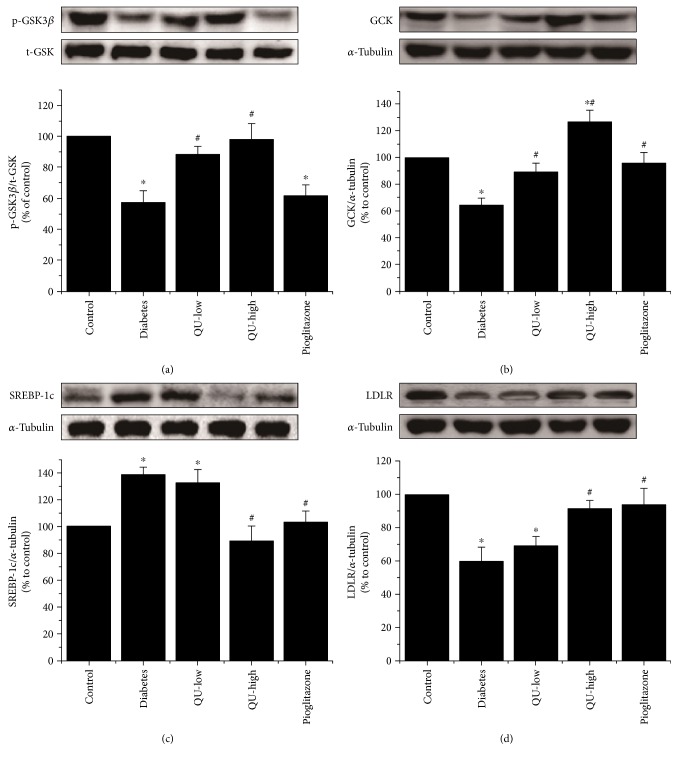
Effects of quercetin on (a) GSK-3β, (b) GCK, (c) SREBP-1c, and (d) LDLR expression. The effects of quercetin on (a) GSK-3β, (b) GCK, (c) SREBP-1c, and (d) LDLR expression in the livers of control, diabetes, QU-low, QU-high, and pioglitazone-treated rats were examined through Western blot. Data are means ± SD, n = 8. ∗P < 0.05 versus control group and #P < 0.05 versus diabetic group by ANOVA.